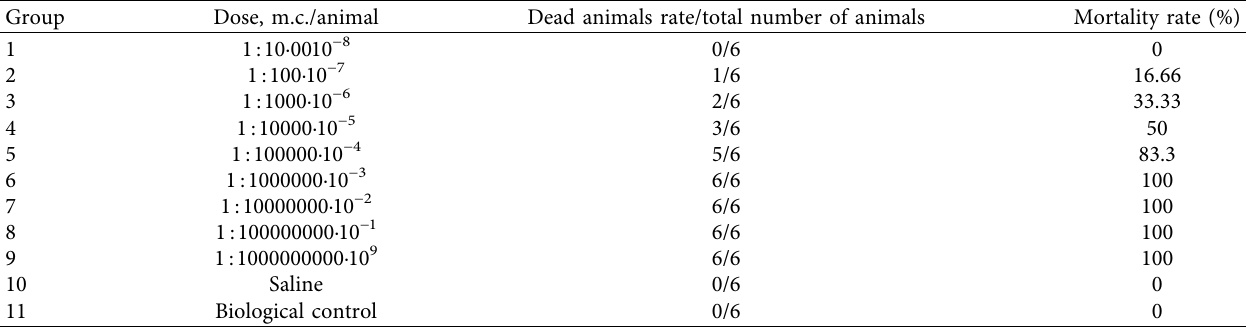
Table 1: Dose-dependent survival rate of rabbits infected with Pasteurella cultures. Group Dose, m.c./animal Dead animals rate/total number of animals